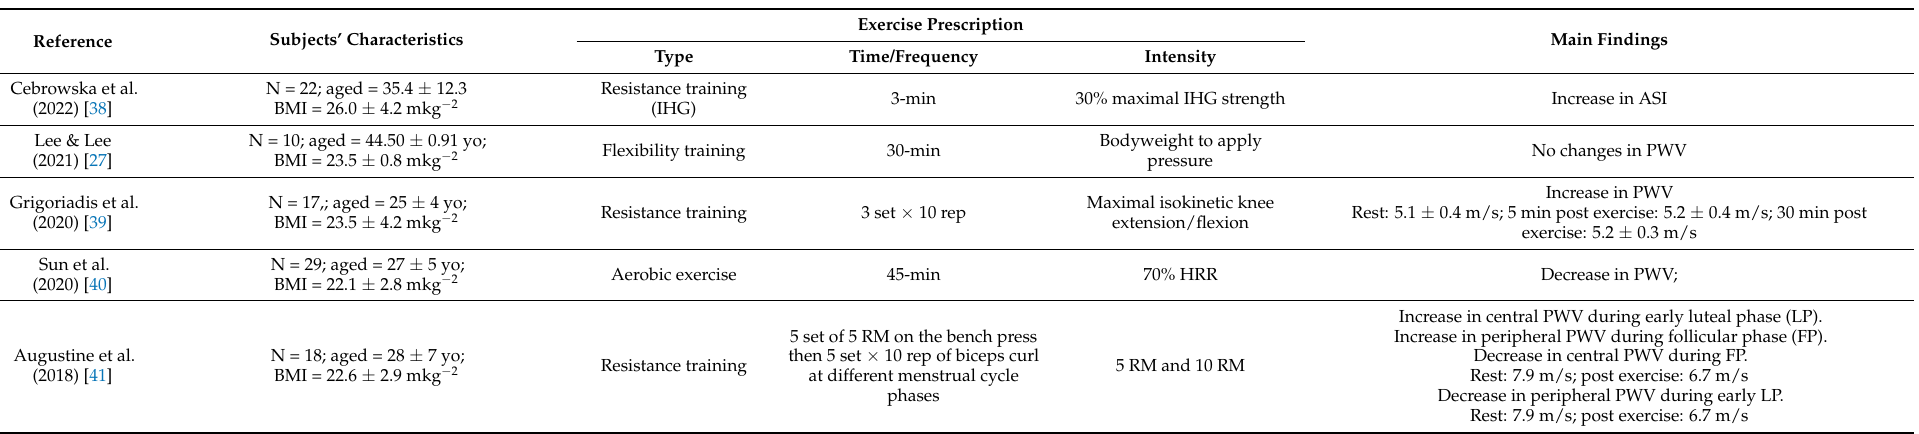
Table 3. Characteristics of selected experimental trials in middle-aged women (n =